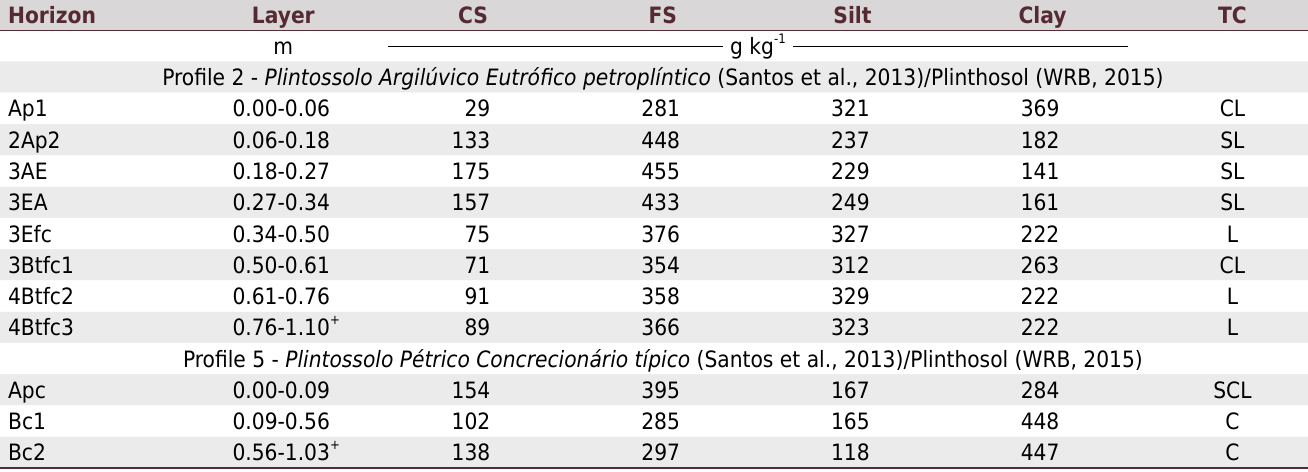
Coarse sand, fine sand, silt, and clay determined by densimeter method (Donagema et al., 2011). CS = coarse sand; FS = fine sand; TC = textural class; CL = clay loam; SL = sandy loam; L = loam; SCL = sandy clay loam; C =